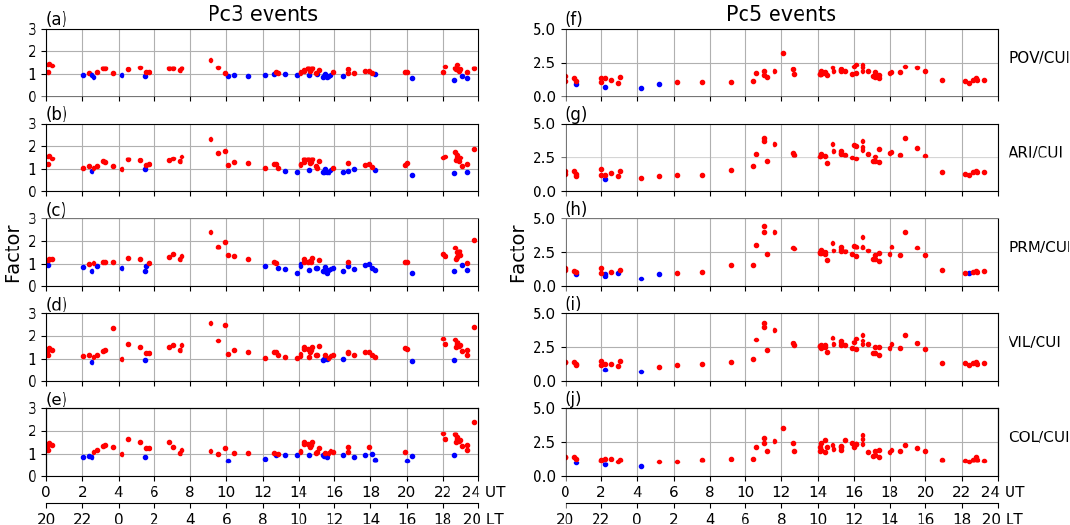
Figure 6. Local time dependence of occurrence distributions of Pc3 and Pc5 relative amplitudes at the equatorial stations. In red are values greater than one (amplification); in blue are values less than one